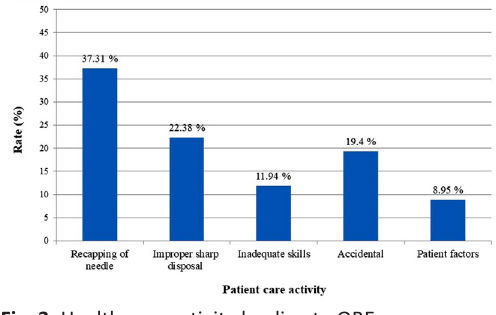
Fig. 3. Health care activity leading to